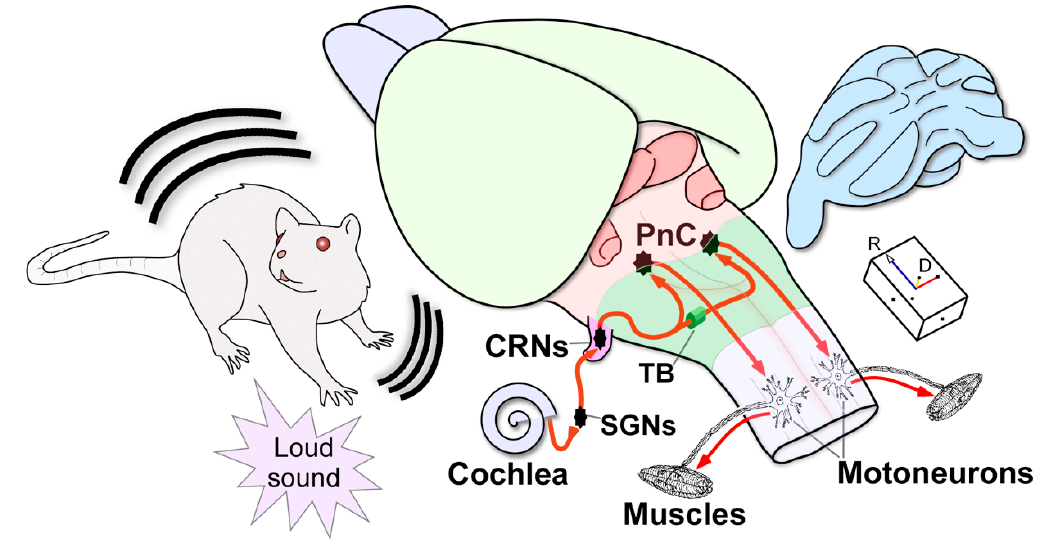
Figure 1. Three-dimensional (3D) schematic drawing of the primary acoustic startle circuit in the rat. Firstly, a sudden loud sound activates the sensory hair cells in the cochlea. Next, the spiral ganglion neurons (SGNs) innervate the cochlear root neurons (CRNs), which comprise the first relay in the brainstem, exhibiting a secure neuronal response with first-spike latencies of approximately 2.2 ms. Then, this short-latency input is quickly transmitted through bilateral projections via the trapezoid body (TB) to the giant neurons in the pontine reticular nucleus (PnC) that produce short-latencies of 5.2 ms. Finally, acoustically driven PnC neurons innervate motoneurons in the spinal cord to elicit the acoustic startle reflex with electromyographic responses of 6–10 ms. The arrowheads indicate the flow of neuronal information within the circuit. Projections from CRNs to other non-auditory nuclei, which are implicated in the full expression of the acoustic and pinna reflexes, are not depicted in this drawing. Abbreviations: CRNs, cochlear root neurons; D, dorsal; PnC, pontine reticular nucleus (caudal part); R: rostral; SGNs, spiral ganglion neurons; TB: trapezoid body.